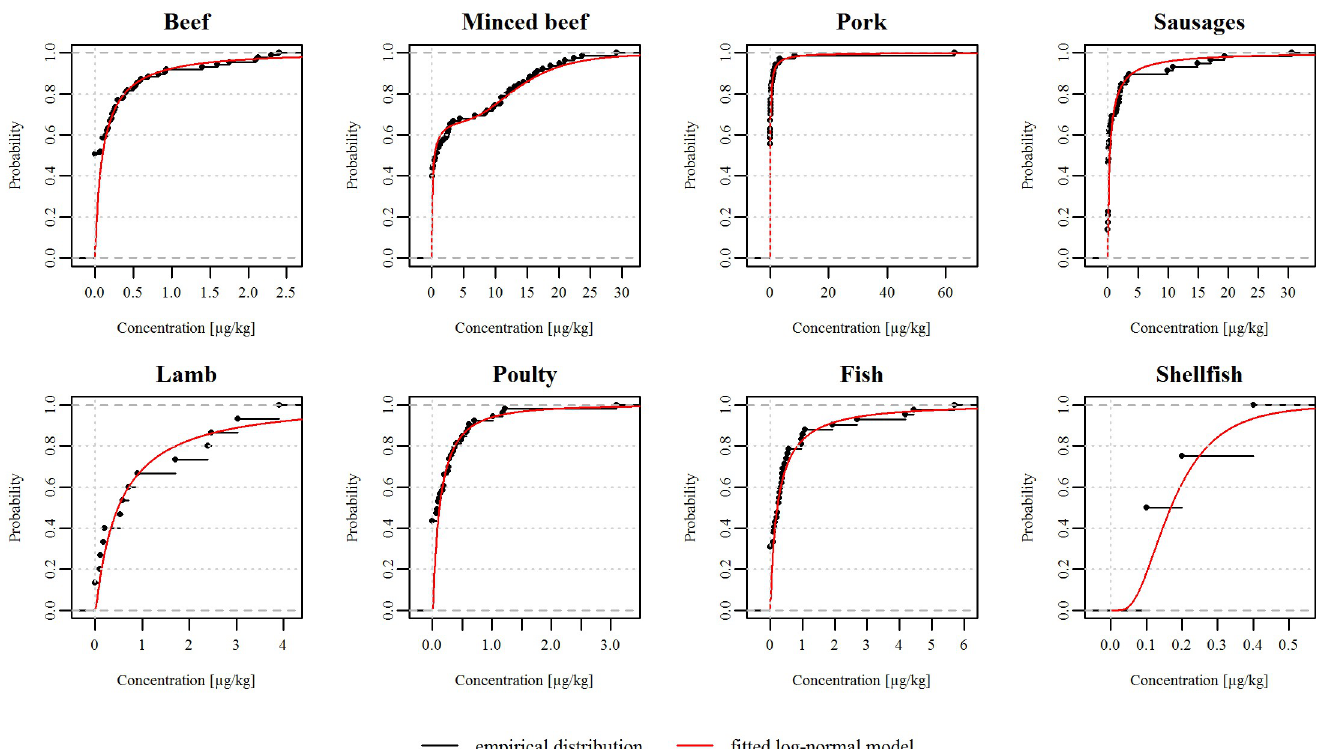
Fig 3. Empirical and theoretical cumulative distribution functions for concentration of benzo[ a ]pyrene in each meat type. The red lines in each graph represent the log-normal distributions fitted to the concentrations. The black lines depict the empirical distributions and the black marks represent the observed concentrations of benzo[ a ]pyrene (in μg / kg ) of each sample of each meat type.